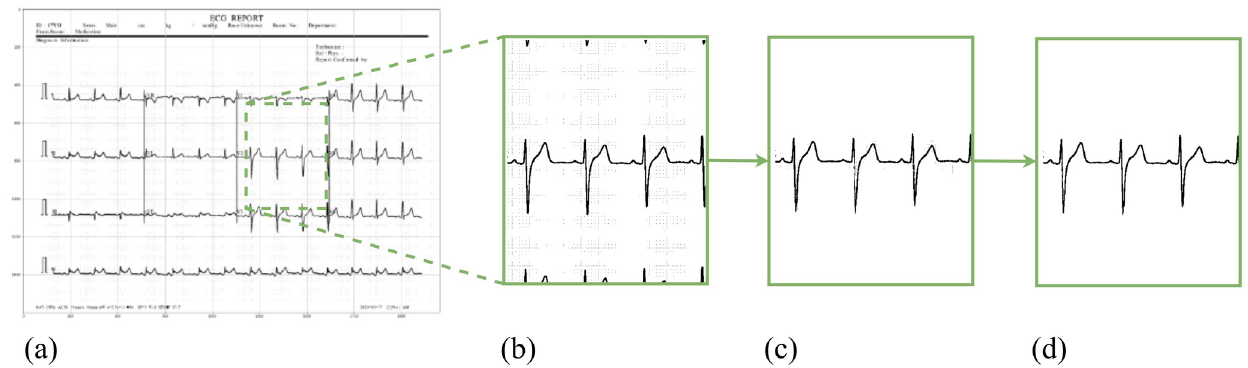
Fig 4. Image processing for ECG signal extraction. (a) is a binary image of the ECG signal, (b) is an image of the lead V2 signal cropped from (a) , (c) is the image of signal after removing noise and artifacts. In (c) , there are small noise spots around the signal. These spots were filtered out in (d) , leaving only the ECG signal